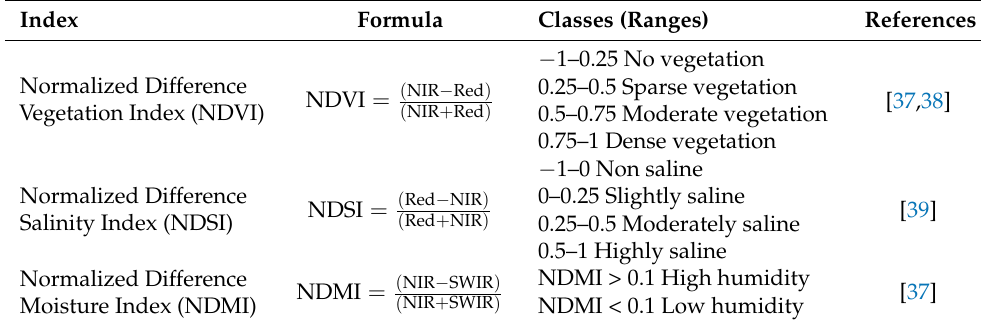
Table 1. Spectral indices formula and classes used in the present